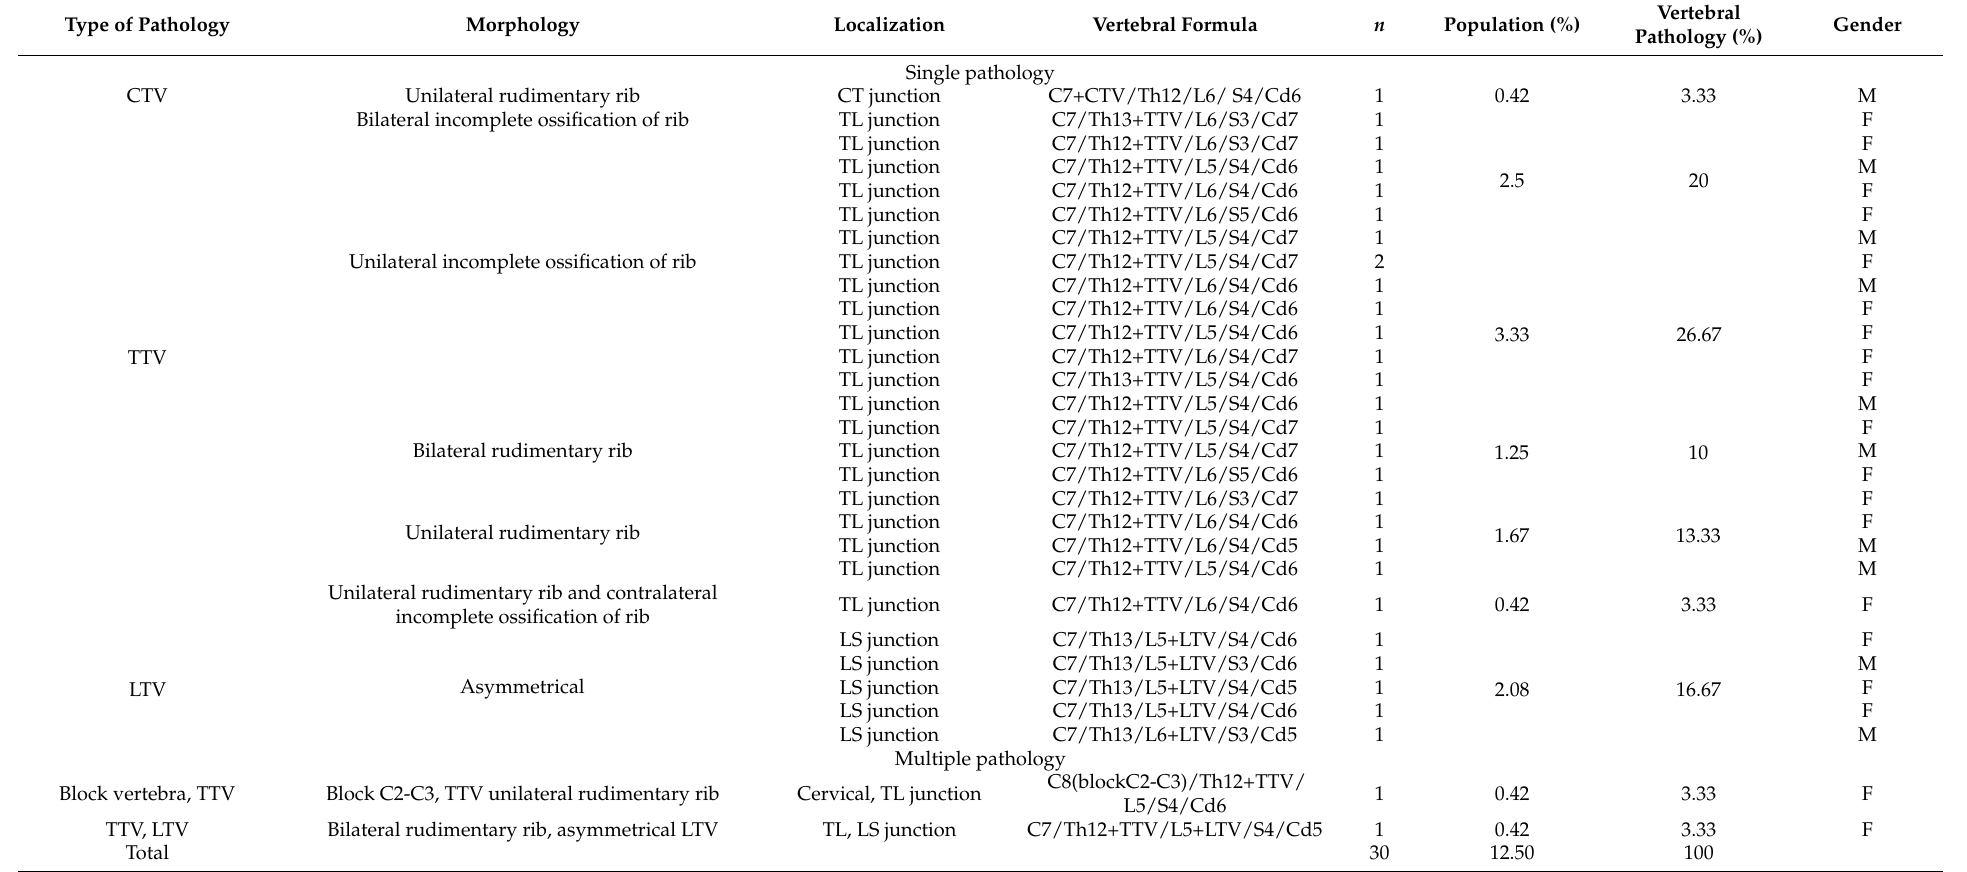
Table 2. Prevalence of congenital vertebral column anomalies in guinea pigs ( n =